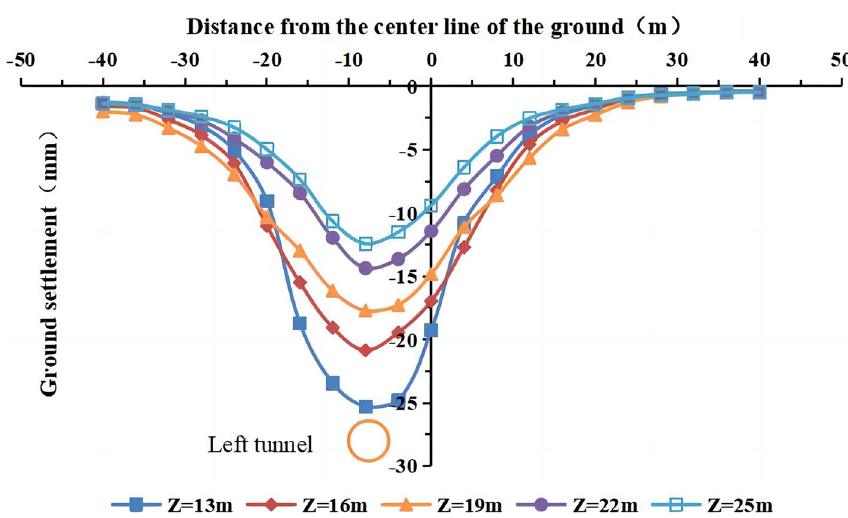
Figure 25. Surface settlement during single-line excavation for different buried